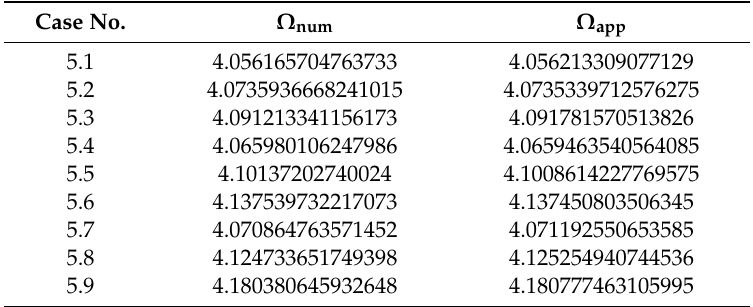
Figure 21. Phase plane for A = 0.4, L = 0.6. Numerical Figure 19. Phase plane for A = 0.3, a = 0.6, L = 0.6. _____ numerical_ _ _ _approximate solution (47). Figure 19. Phase plane for A = 0.3, a = 0.6, L = 0.6. numerical approximate solution (47). Table 1. Comparison between the numerical solution of the frequency and the approximate approximate solution (50). frequency (36). Case approximate solution (50).